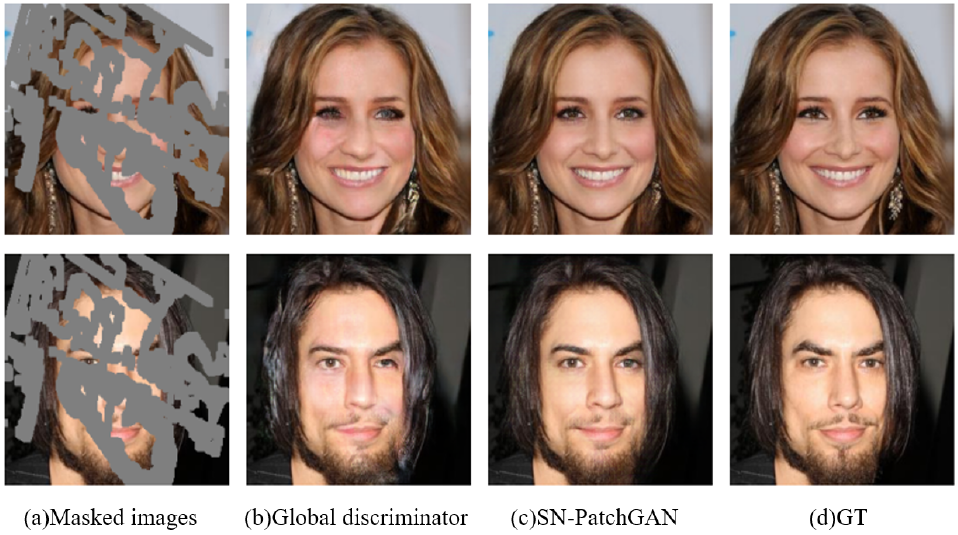
Figure 9. Comparison of SN-PatchGAN discriminator and global discriminator completion